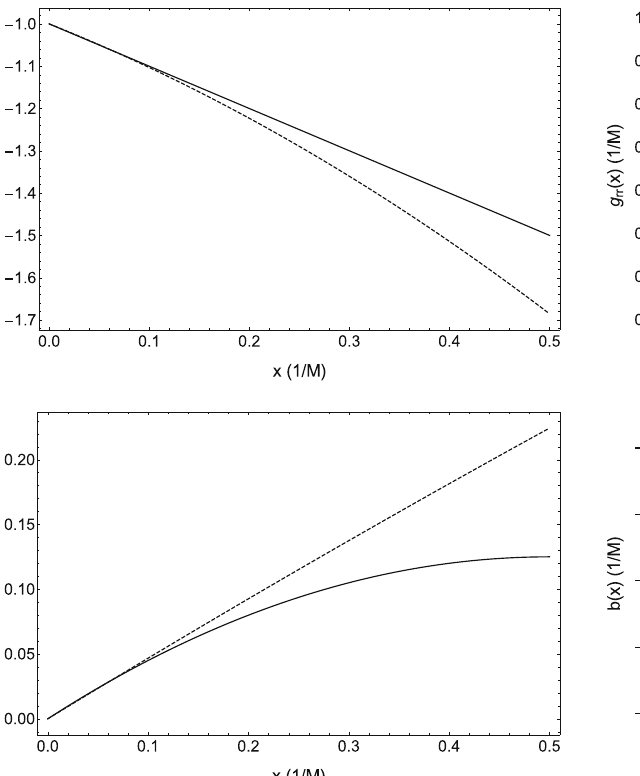
of R ∞ = 10 . 00 Kpc, ε = 0 . 111828 Kpc − 1 for the expansion of the Yuakawa potential, and the best fit values for the modified potential (26) are λ = 1 Kpc − 1 , and α = 0 . 01 for f ( R ) theories, and d 0 = 0 . 56, d 1 = − 0 . 12, L 0 = 3 . 77, L 1 = 1 . 95 for R + α 0 R 2 + α 1 R (cid:2) R